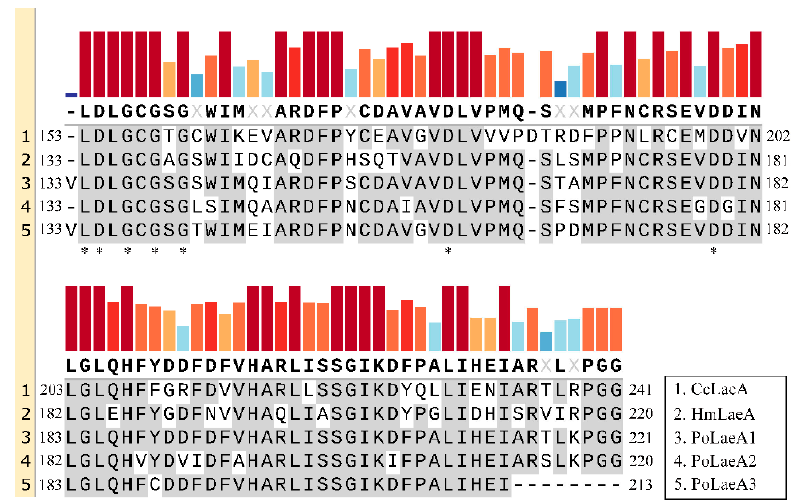
Figure 1. Amino acid sequence alignments of the conserved domain in LaeA-like proteins from basidiomycetes. The conserved domains were identified by Pfam (https://pfam.xfam.org/, accessed on 16 May 2022). The GenBank accession numbers for the LaeA-like proteins are Coprinopsis cinerea CcLaeA (XP_001829319, accessed on 16 May 2022) and Hypsizygus marmoreus HmLaeA (RDB28437, accessed on 16 May 2022). The results were constructed with SnapGene software (version 6.0.5) using the multiple sequence comparison function. Asterisks indicate the putative S-adenosylmethionine (SAM) binding sites in the conserved domain.